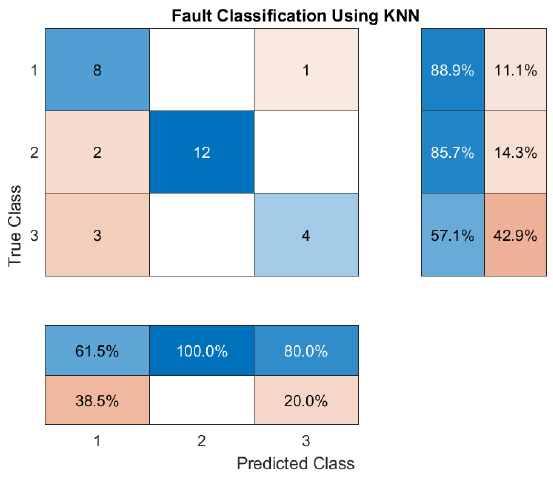
Figure 9. Confusion Matrix for k-NN Univariate Model. Table 9. k-NN Univariate Performance.